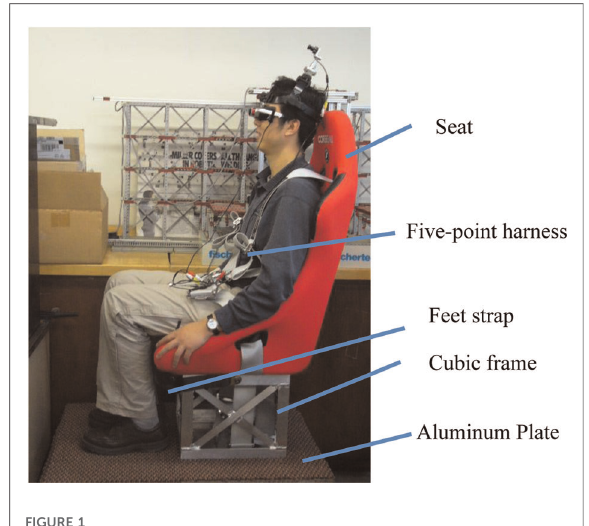
FIGURE 1 Seating system con fi